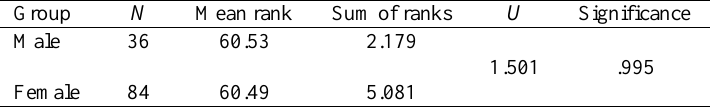
Table 2 Analysis of the Mann-Whitney U test results on the ‘gender’ variable Group Significance